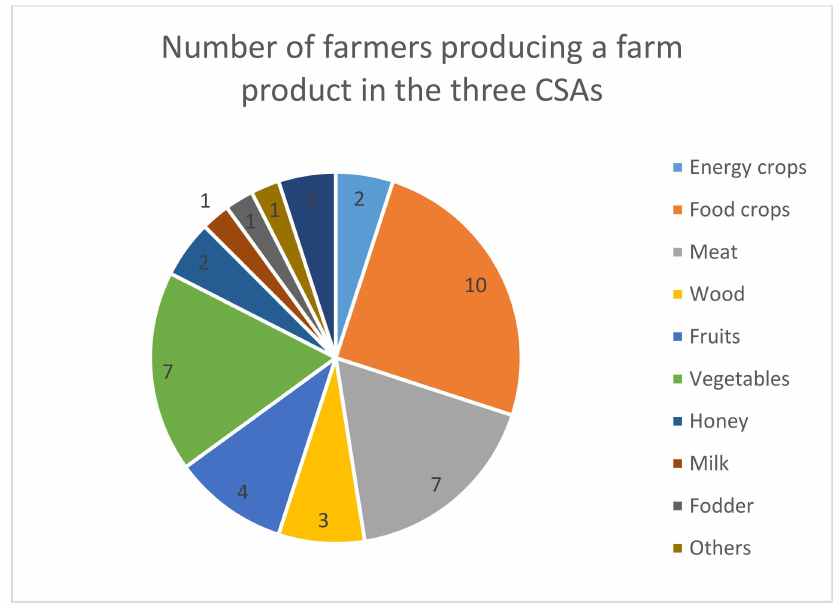
Figure A2. Variety of farm products produced in all three CSAs.